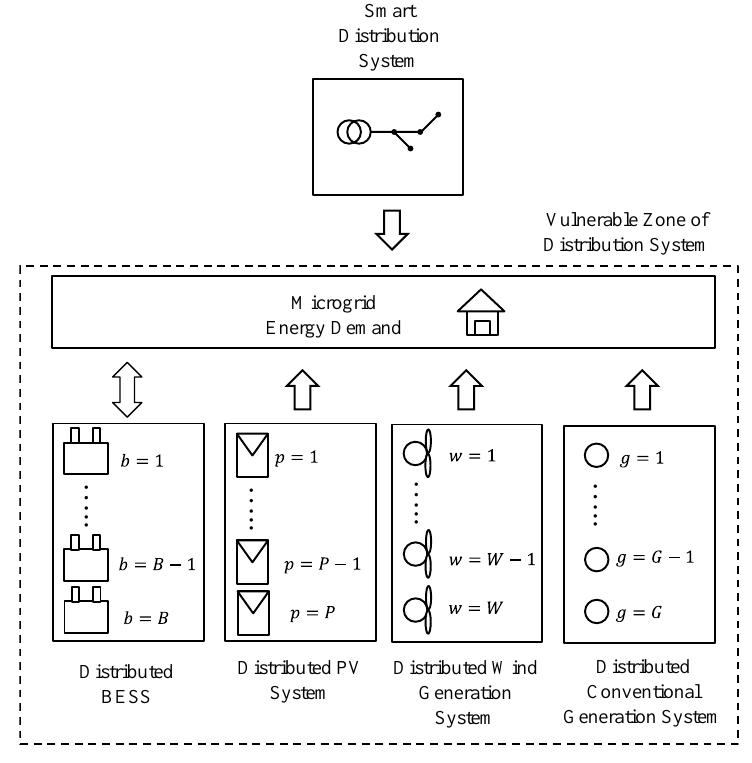
Figure 1. General structure of energy system.